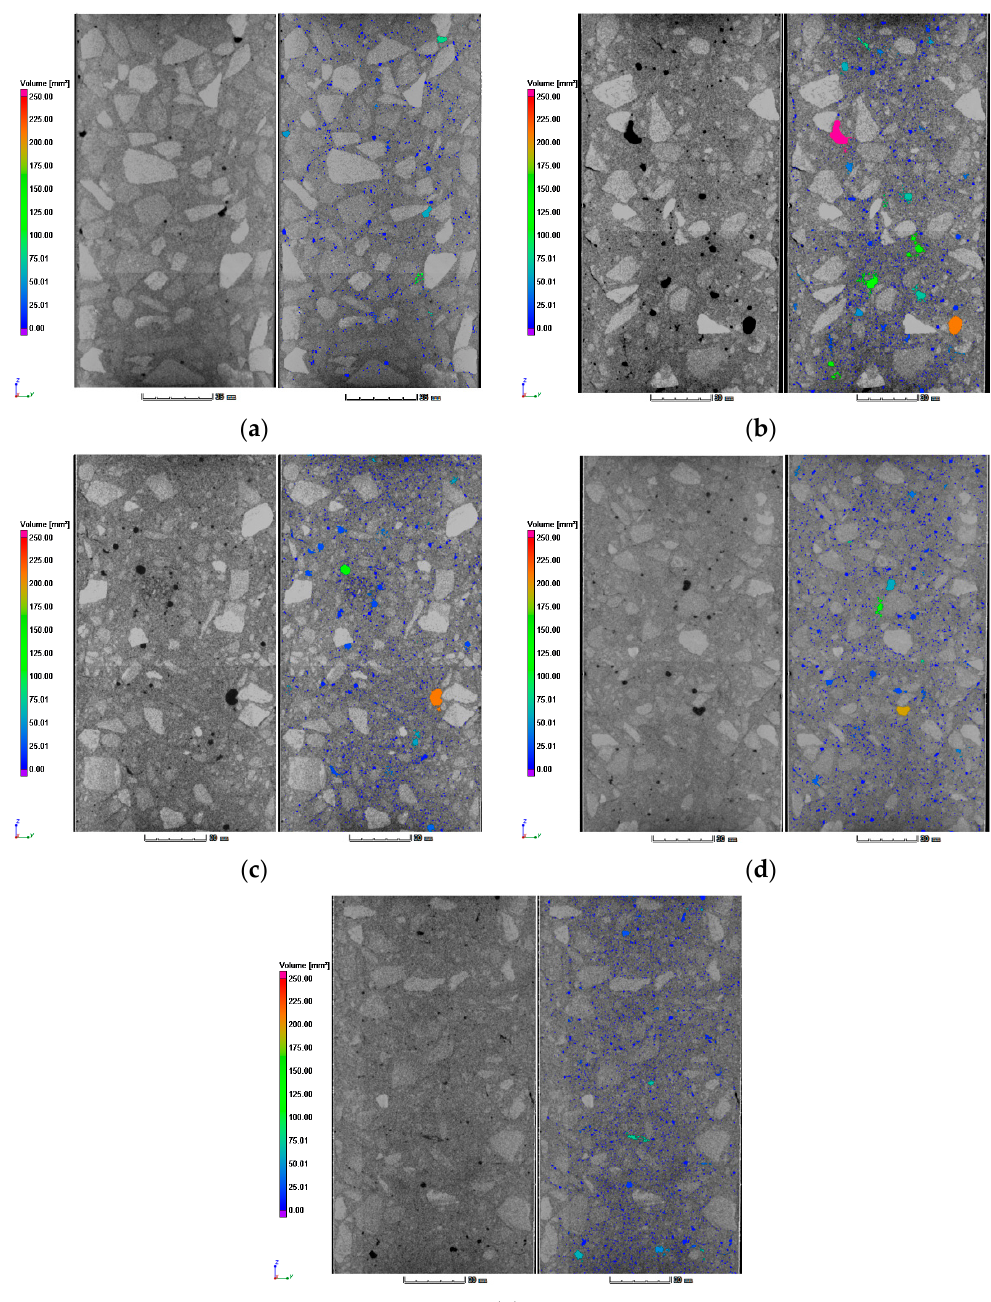
Figure 20. Front view of ICT images before and after porosity analysis: ( a ) NC; ( b )FRC01 no fiber; ( c ) FRC05 with 0.08% fibers; ( d ) FRC06 with 0.12% fibers; ( e ) FRC07 with 0.16% fibers.